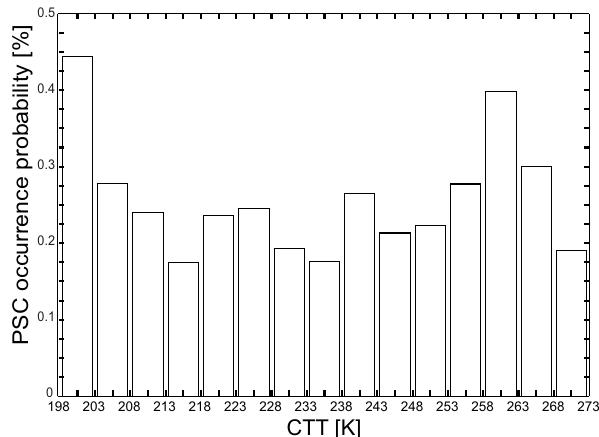
Fig. 5. Observed probability of PSC occurrence ( f PSC ) with respect to the cloud top temperature (CTT) of all observed tropospheric clouds during the time period from December 2007 to February 2008 in steps of